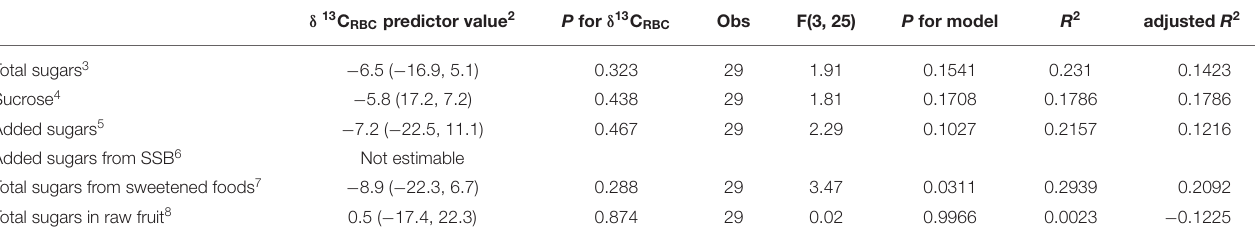
TABLE 6 | Associations between dietary sugars intakes (g/d) and δ 13 C RBC from a multivariate log linear regression model 1